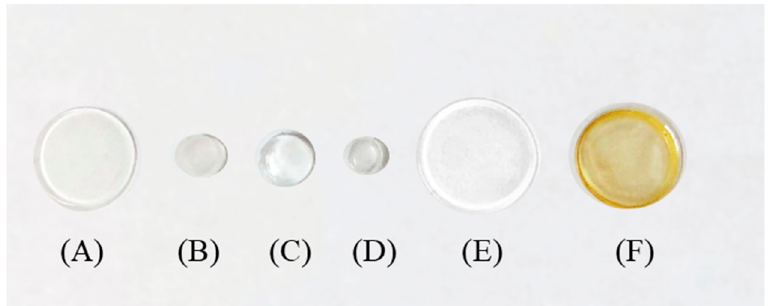
Figure 4. Different support material tested in order to immobilize luminol. ( A , B ) PDMS with different size; ( C – E ) PDMS and TEOS with different size; ( F ) zein.